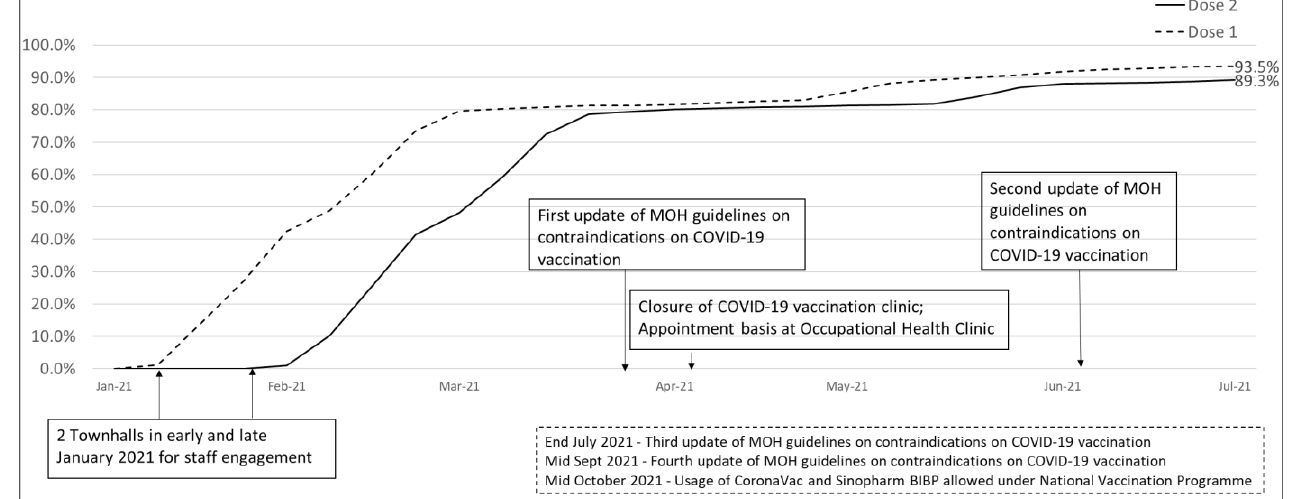
Figure 1. Timeline of COVID-19 vaccination exercise.